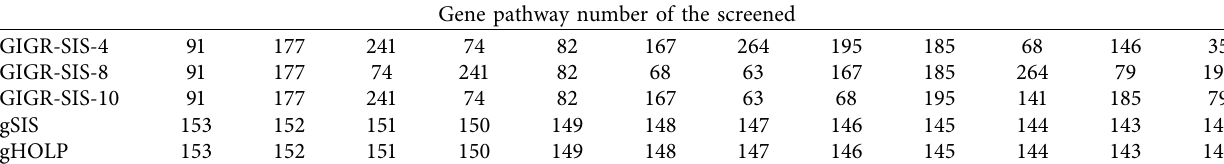
Table 8: P53 data screened for gene